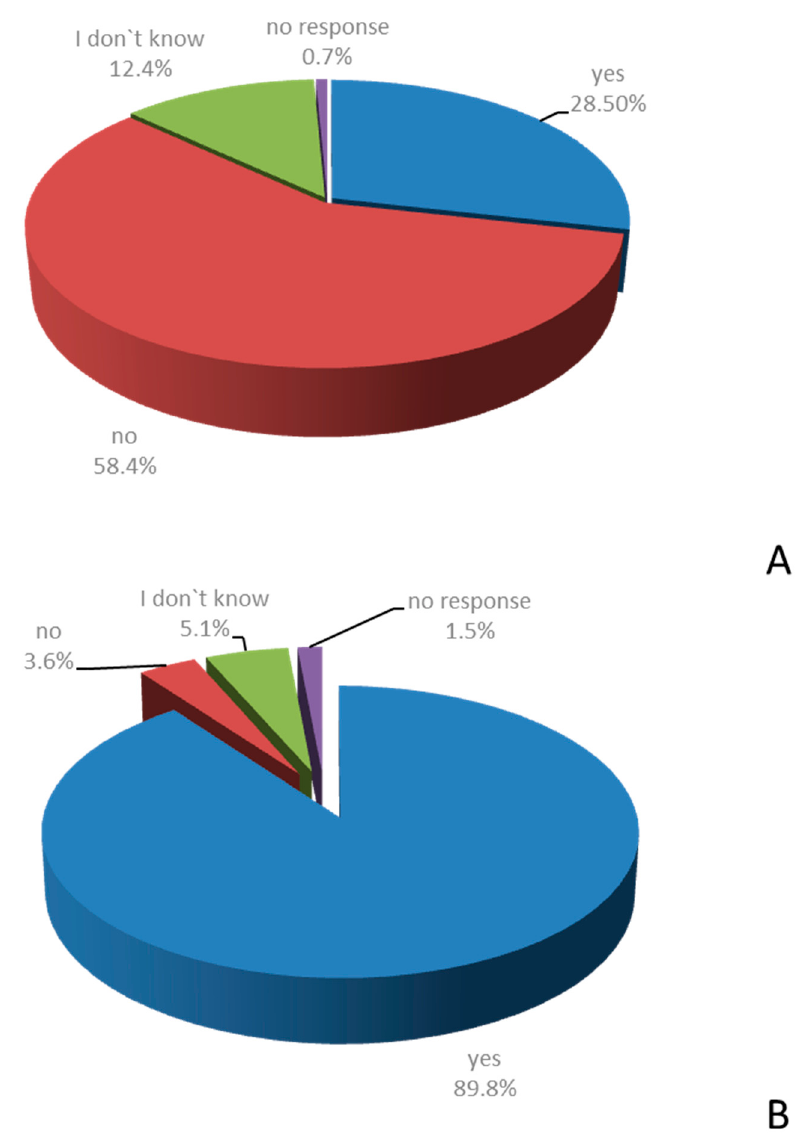
Figure 4. Agreement with statements on the personal experience with SUP in the clinical routine. MSMs were asked whether they agree or disagree with the following statements: “I feel